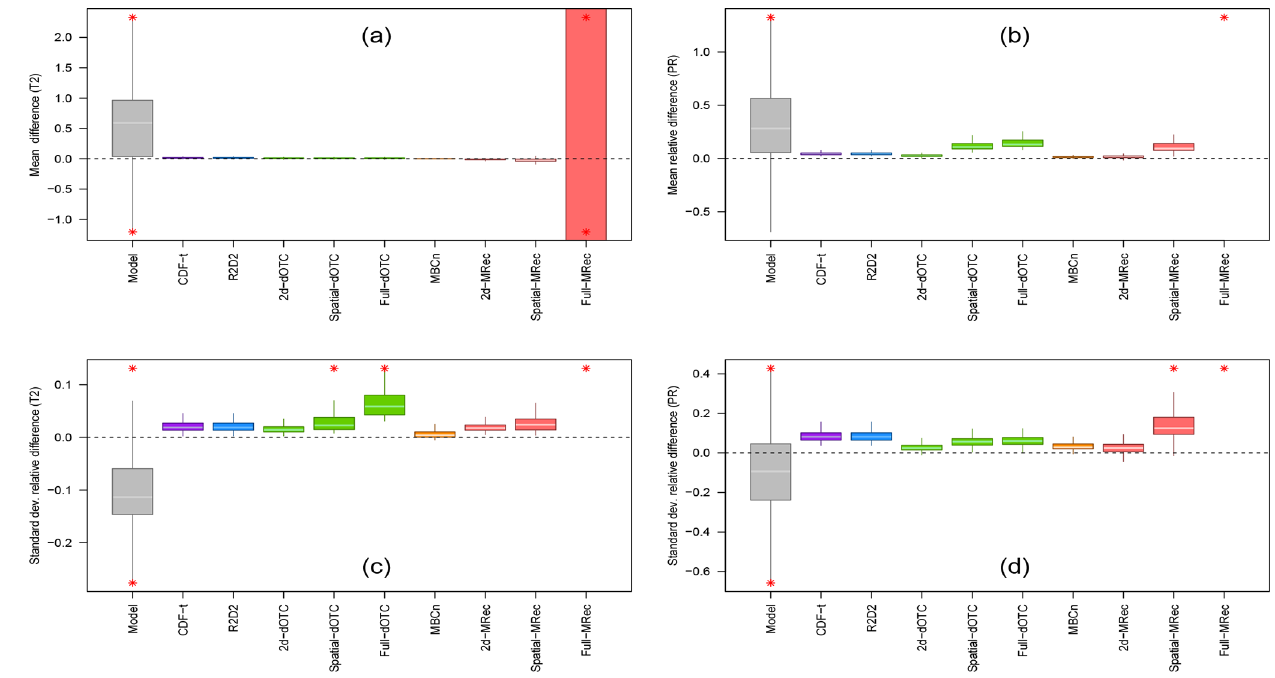
Figure 1. Boxplots of (a, b) mean and (c, d) standard deviation differences for (a, c) temperature (T2) and (b, d) precipitation (PR) during winter over the 1979–2016 period for France (WFDEI reference). Results are shown for plain IPSL, CDF-t, R 2 D 2 , dOTC (2d-, Spatial- and Full- versions), MBC-n and MRec (2d-, Spatial- and Full- versions) outputs. Red asterisks indicate values lying outside the plotted